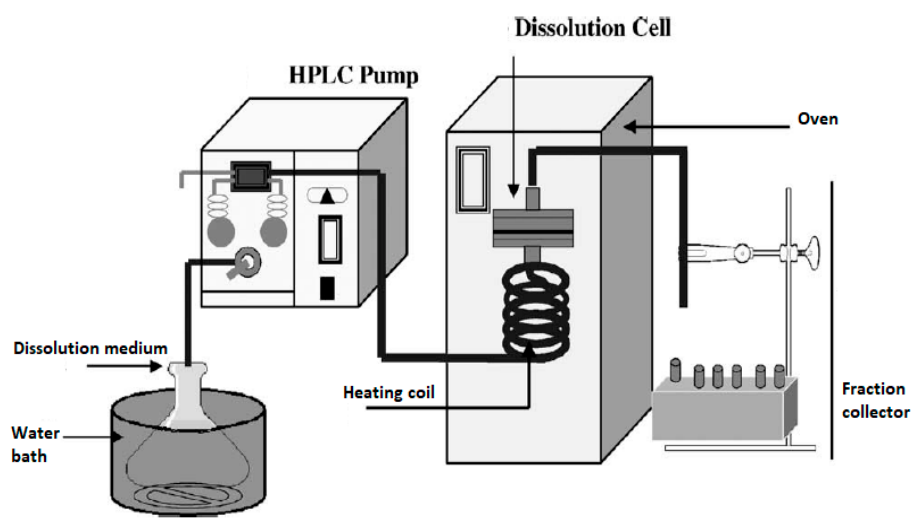
Figure 5. A fl ow through cell dissolution apparatus (the fi gure was taken from reference [4]). Figure 5. A flow through cell dissolution apparatus (the figure was taken from reference [4]).